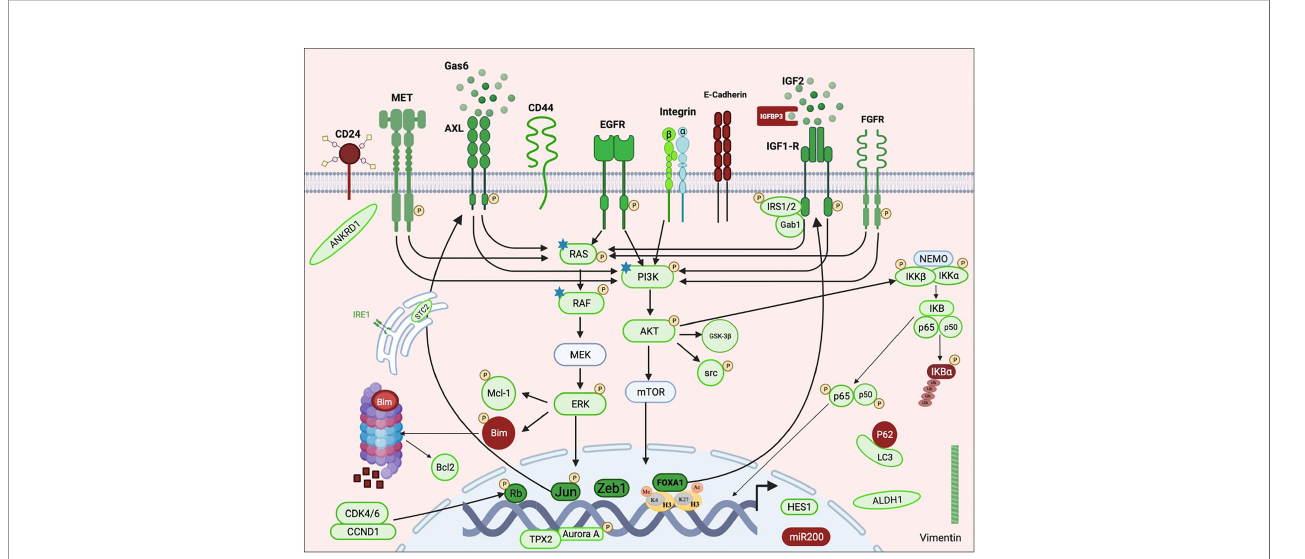
FIGURE 1 | Schematic representation of an overview of pathways implicated in resistance emergence to third-generation EGFR-TKIs. Mechanisms of resistance to third-generation EGFR-TKIs include aberrant activation of receptor tyrosine kinases (MET, AXL, IGF1-R, FGFR, and EGFR) and/or the downstream pathways (PI3K/ AKT, RAS/MAPK, and NFKB) and histological transformation. RTK activation is due to overexpression of the protein with or without copy number gain, through its transactivation involving transcription factors (e.g., Jun and FOXA1) or consequently to the overexpression of its speci fi c ligand (e.g., IGF2 and GAS6). Activation of the downstream cascades can also be due to somatic mutations (e.g., RAS, RAF, and PI3K). Histological transformations consist of EMT and EMT-related stemness features including downregulation of E-cadherin and miR200 family, upregulation of Vimentin, Zeb1 and ANKRD1, enrichment in CD44 hight /CD24 low and ALDHA1 hight populations, HES1 overexpression, and autophagy activity. Resistance also required apoptosis modulation through Bim degradation and Bcl-1 upregulation. Non- classi fi ed resistance mechanisms include activation of AURKA and its coactivator TPX2 and upregulation of CDK4/6 and IRE1. Green color indicates activation or overexpression; red indicates down-regulation. P: phosphorylation. Star: point mutation. This fi gure was created using the free version of the Biorender